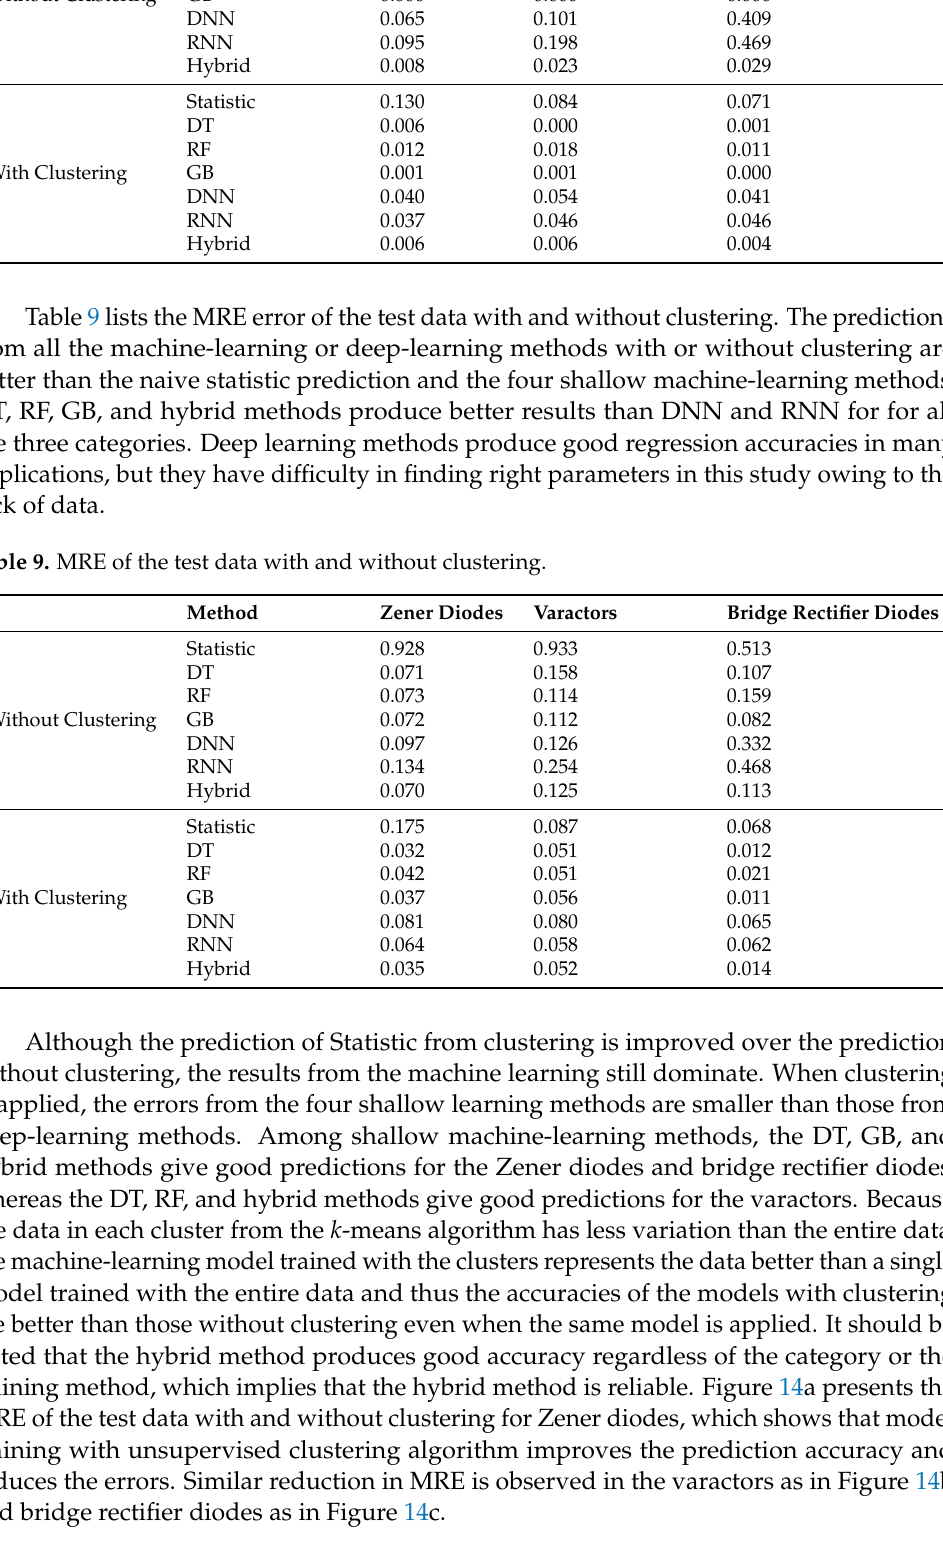
Table 8. MRE of the training data with and without clustering.